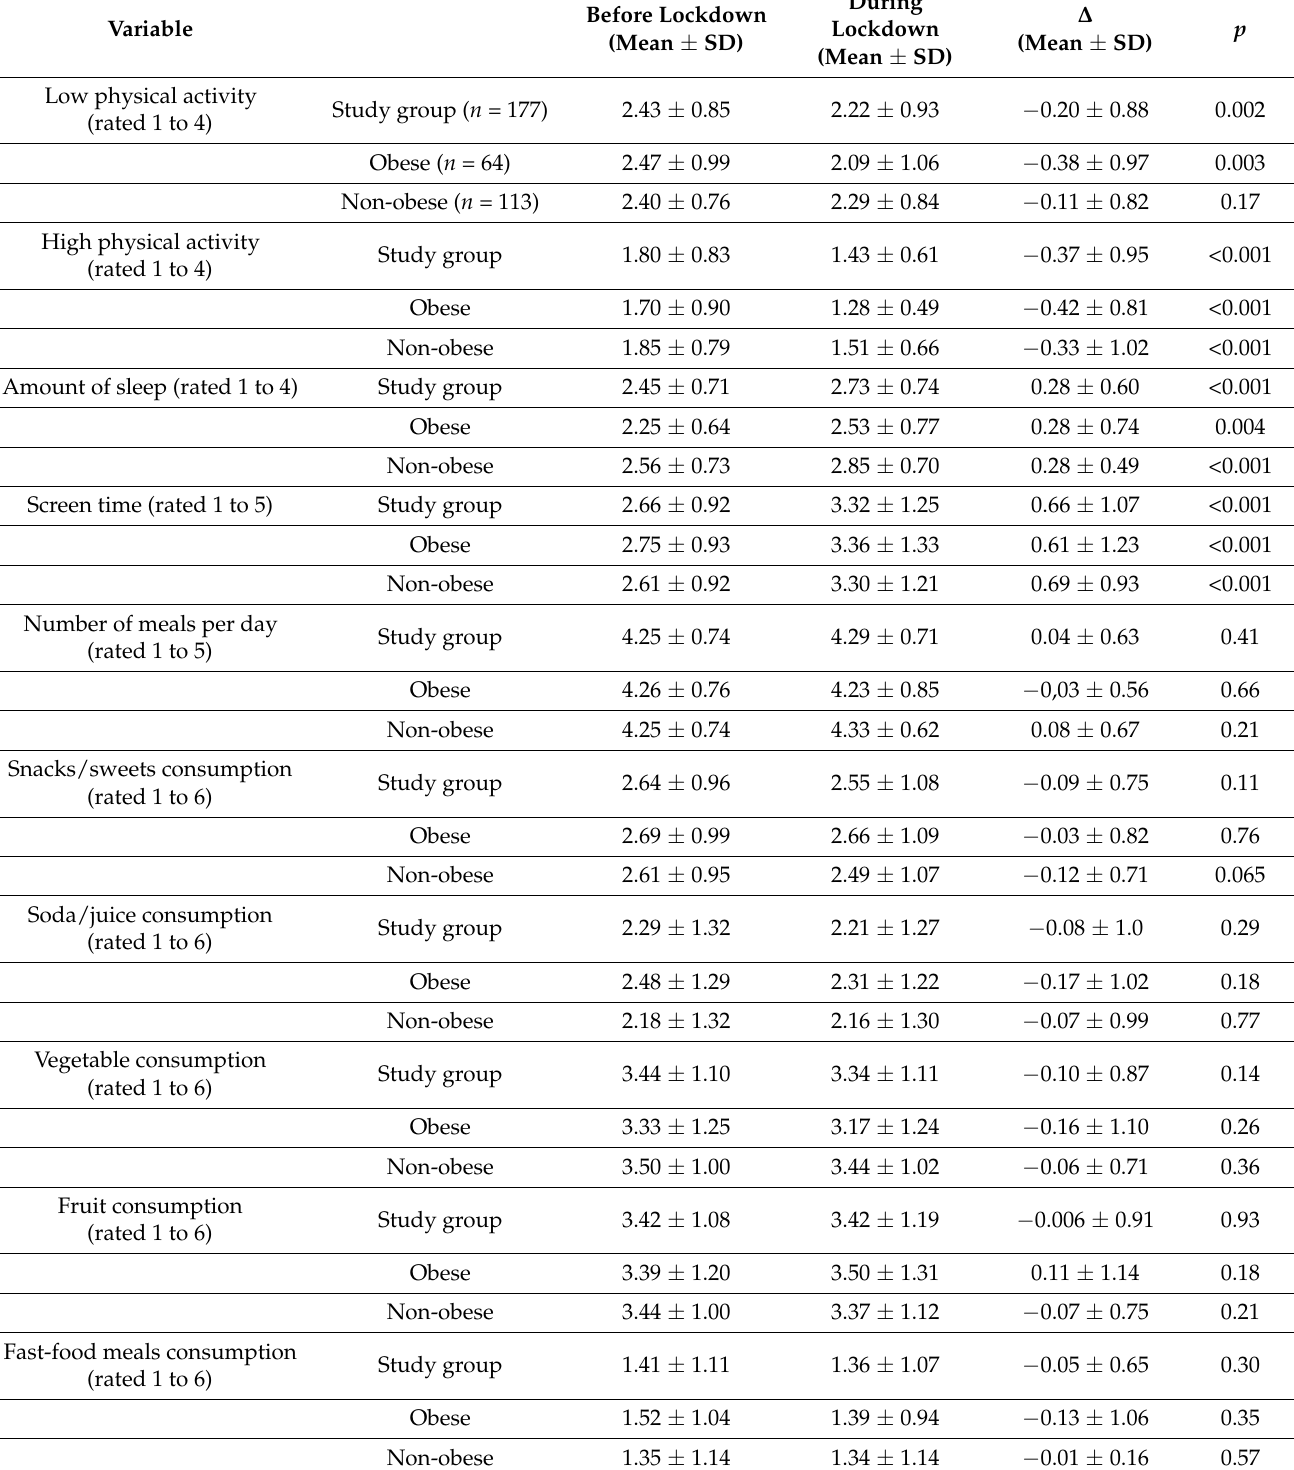
Table 4. Physical activity, computer usage, and dietary preferences before and during the